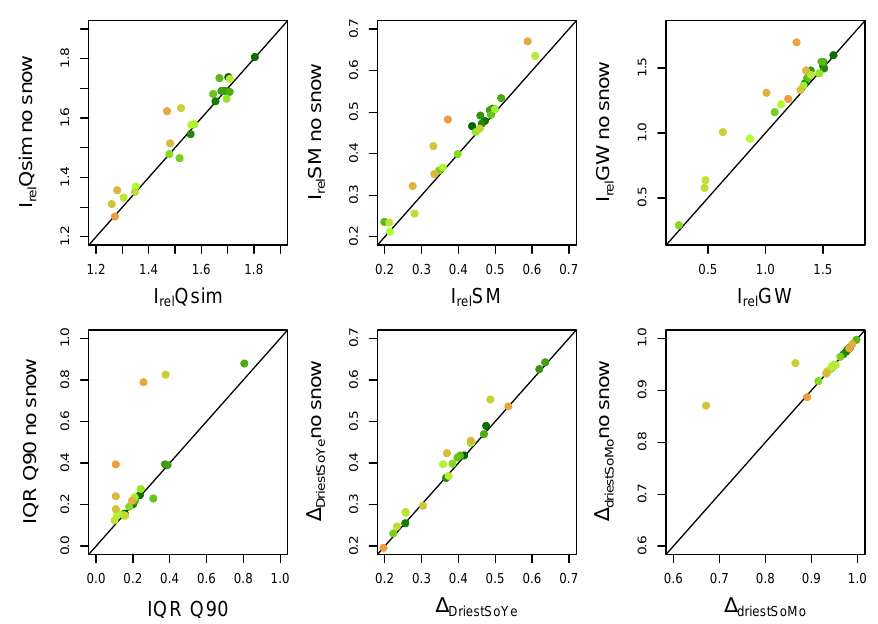
Figure 8. Comparison of the different measures of the sensitivity to drying resulting from simulations in the natural settings and simulations without snow accumulation. The greener colors indicate catchments at (originally) lower mean elevation and the more brownish colors were used for catchments at (originally) higher mean